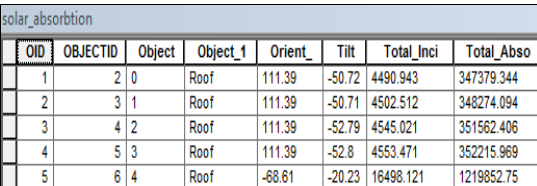
Figure 8. The information in geospatial database